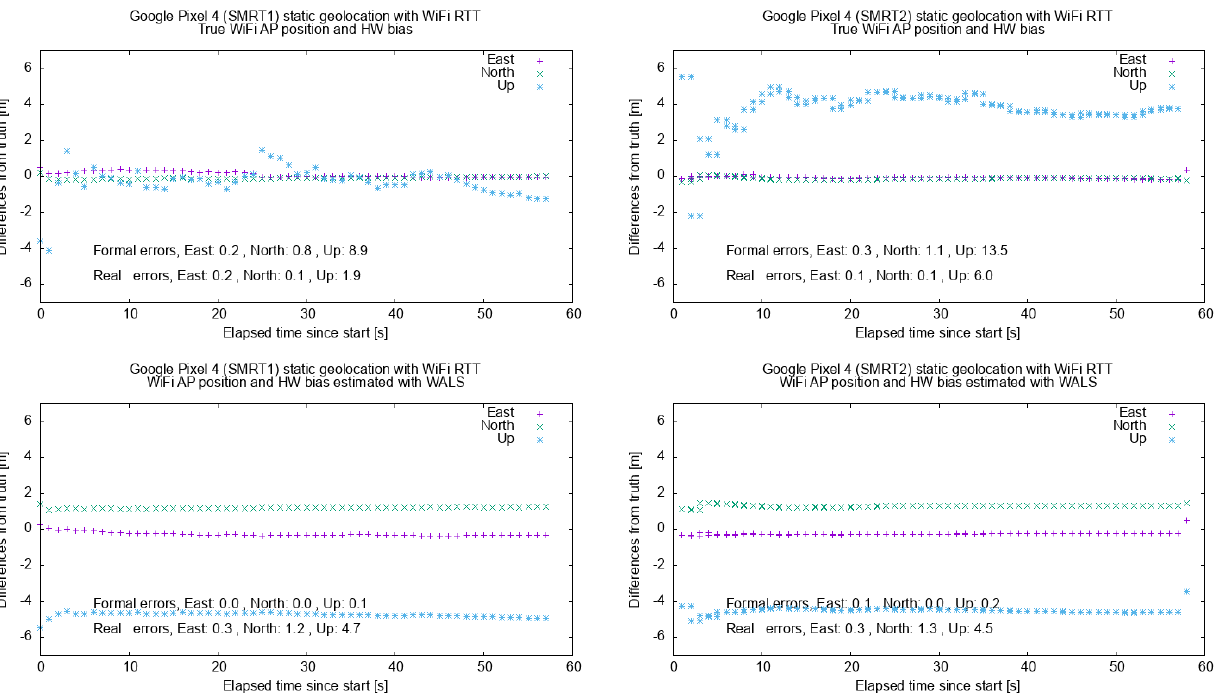
Figure 4. Result for the two Google Pixel smartphones (user terminal) in static positioning using the true WAP position and biases ( above ) and WALS WAP position biases ( bottom